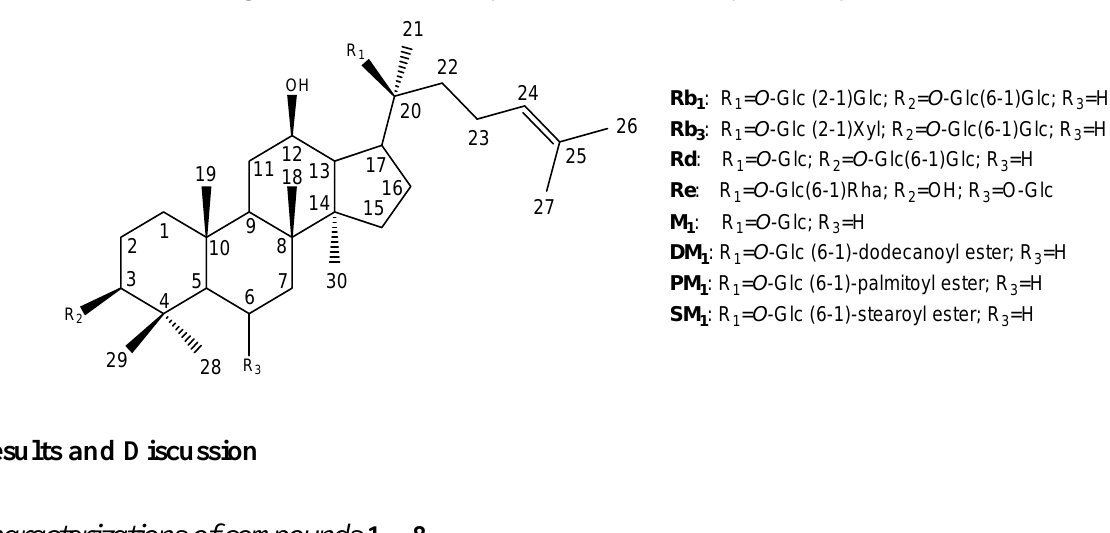
Figure 1. Isolated, enzyme produced and synthetic